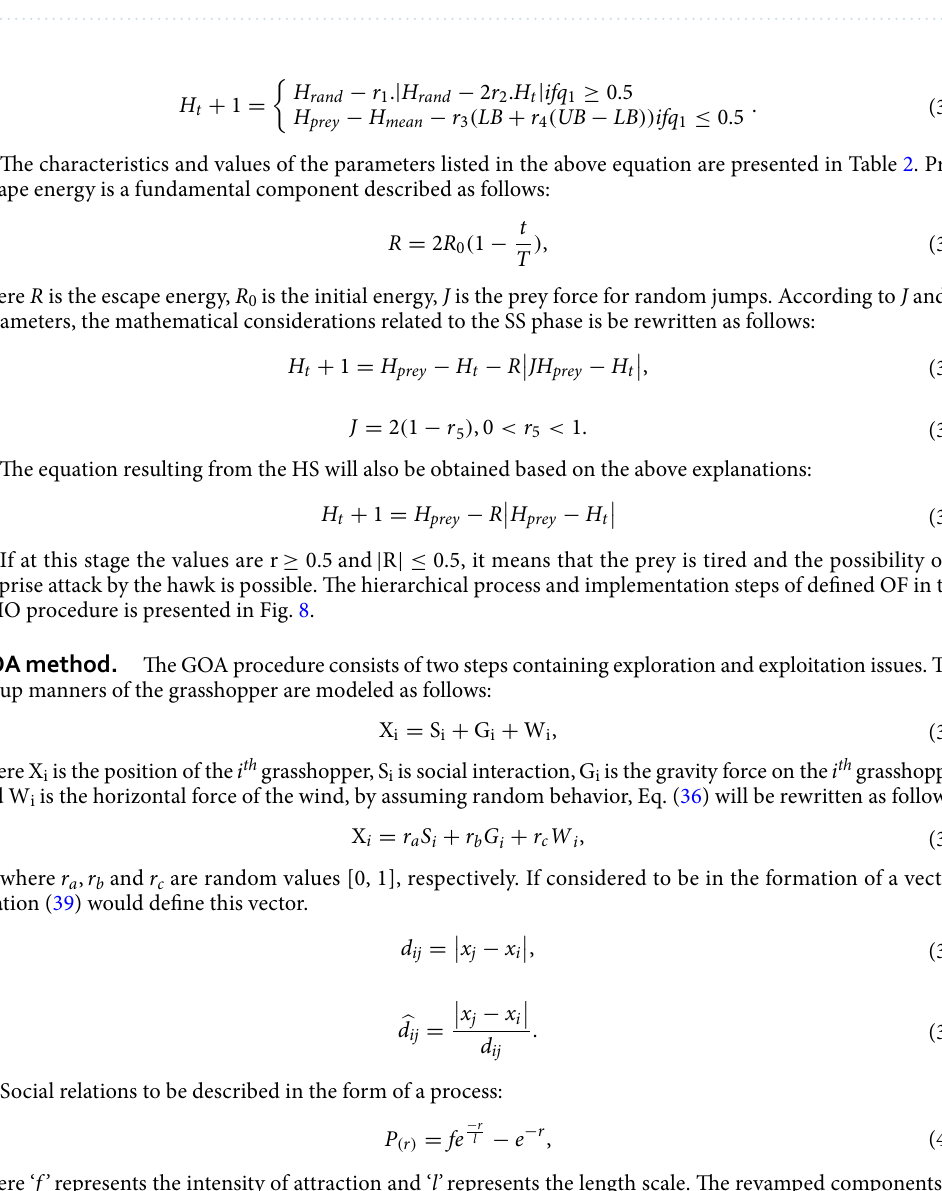
Table 2. The parameters characteristics and values of the HHO